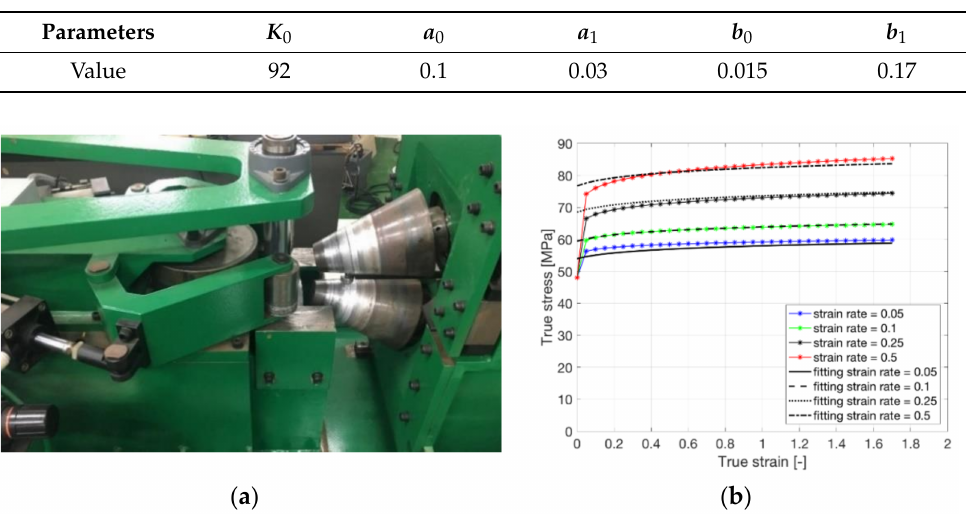
Table A1. Material model constants for the Pb75-Sn25 material.